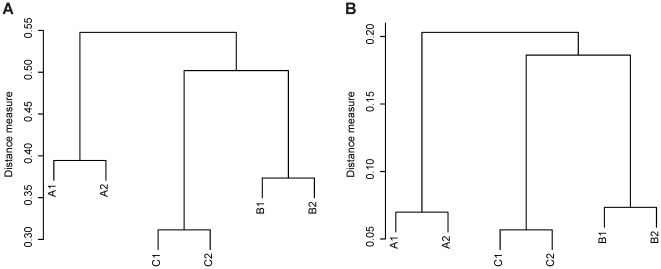
Hierarchical clustering of mass spectrometric (A) and phylogenetic fingerprints (B).Distance as 1-Pearson correlation values are indicated on the vertical axes. Subject-wise clustering implies that the proteomic (averaged over the measurements per sample in set of 22 AMP measurements; see Figure S1) and the phylogenetic fingerprints remain characteristic for each subject over a period of one year.